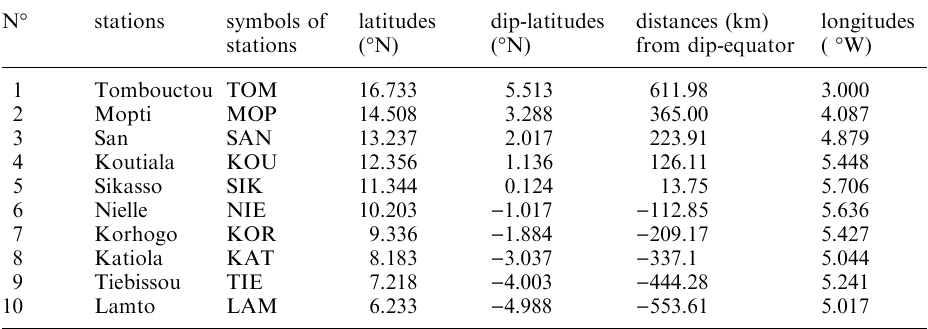
N (cid:176) stations symbols of